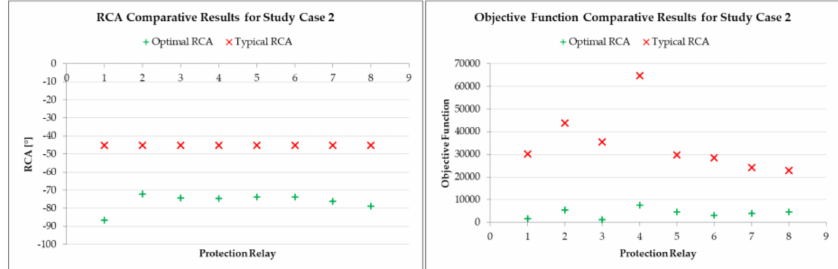
Figure 15. Comparative results for the evaluation of polarization on the directional ground overcurrent element (ANSI 67N) in the protection relays of Study Case 2—zero sequence polarization.